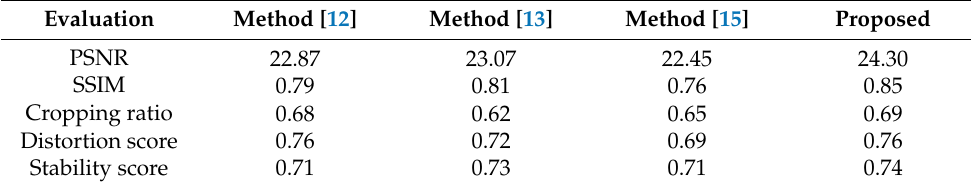
Table 2. Video stabilization effect comparison of video 2.